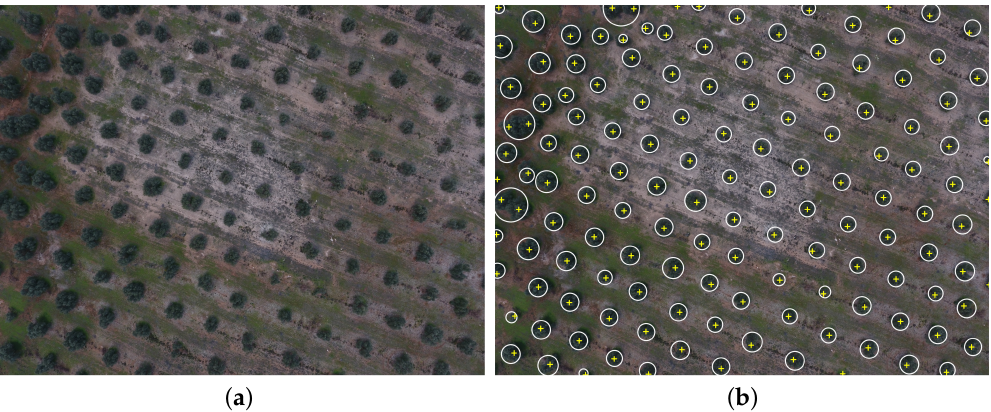
Figure 10. Color-based segmentation results (white circles) vs. ground-truth reference (yellow crosses) for image DJI_0232 (worst case). ( a ) Original image. ( b ) Detected and annotated